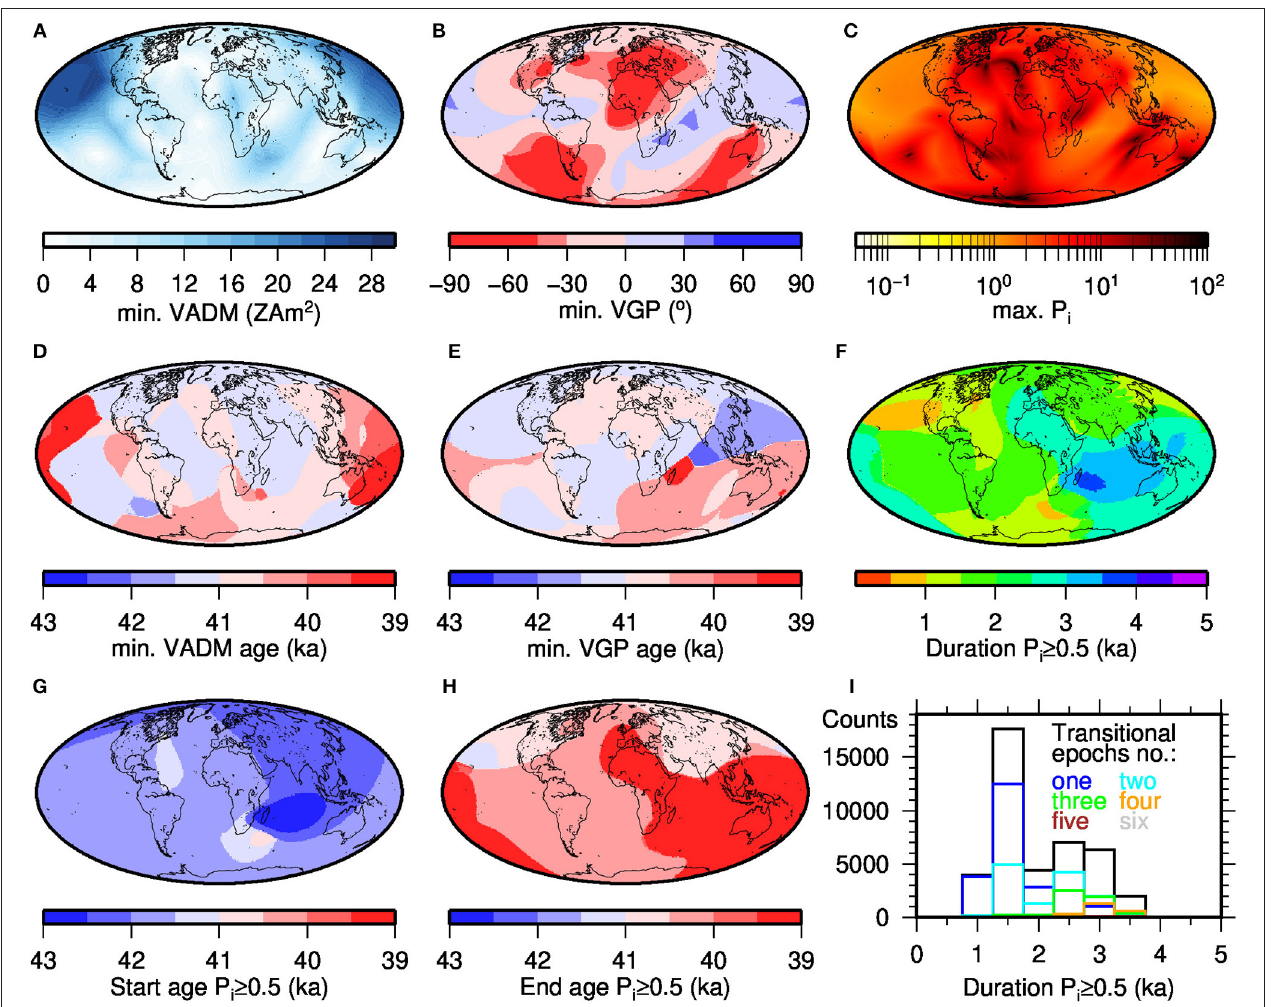
FIGURE 6 | Minimum VADM (A) , VGP ( B , note the non-linear color scale) and maximum P i (C) reached in different areas (at different times) during the Laschamp excursion; ages when minimum VADM (D) and VGP (E) values are reached; (F) regional duration of the excursion according to P i ≥ 0.5 and earliest (G) and latest (H) age of P i = 0.5; and histograms of duration of the Laschamp excursion in 500 years bins (I) according to earliest and latest P i ≥ 0.5 occurrence (black). Colored lines indicate whether P i ≥ 0.5 for the whole duration or whether this time was split into two (cyan), three (green), four (orange), five (brown), or six (gray) intervals between which P i < 0.5. All results are from our preferred model C